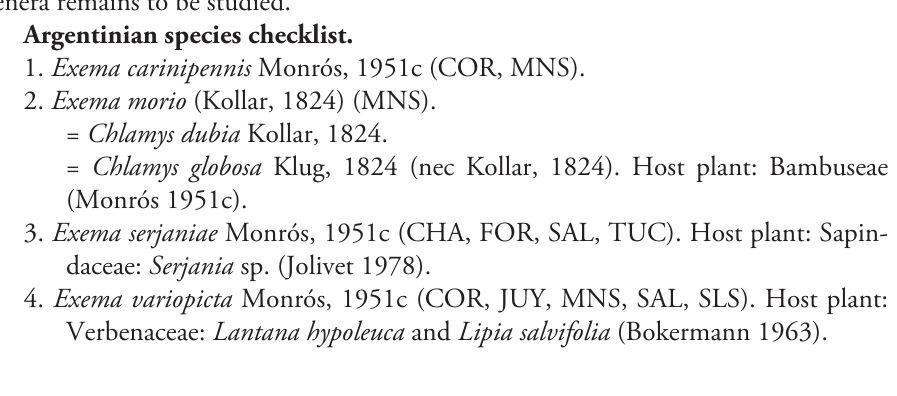
Fig. 31 Fulcidax Voet 1806: 33; Jacoby 1880: 90; Monrós 1951c: 641; Blackwelder 1946: 650; Seeno and Wilcox 1982: 43; Chamorro-Lacayo and Konstantinov 2009: 76. = Poropleura Lacordaire 1848: